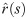
Distribution P(r∣s) of network responses to a stimulus s.Normalized histogram of 105 averages of n random individual neuron firing rates (symbols), and Eq (30) (lines). For evaluation of Eq (30) we calculated the mean stationary network activity r^(s) using the self-consistent Eq (5). The corresponding variance of the sampling noise σ(s)2/n was obtained from the approximate stationary firing rate distribution as previously discussed for Fig 3B. The distributions are broadened by assortativity, corresponding to larger noise of the response of assortative networks.